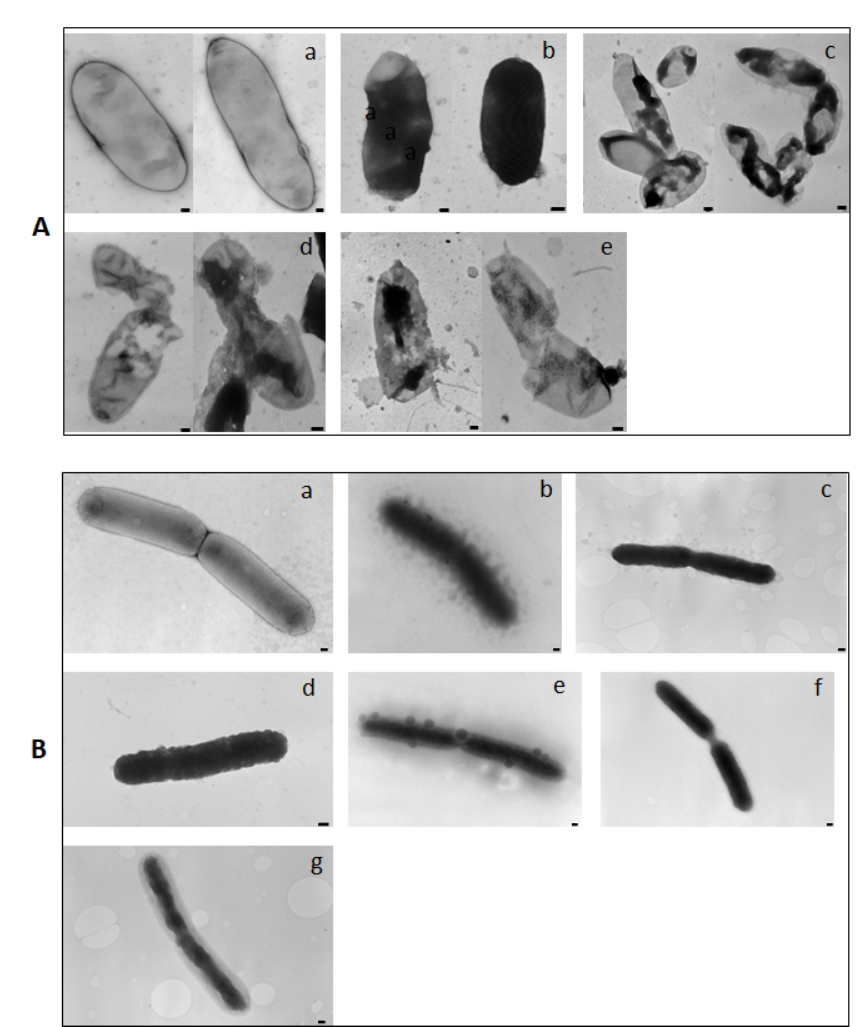
Figure 5. Transmission electron microscopy micrographs showing the bacteriostatic and bacteri- cidal activities of KL29 against Erwinia amylovora ( A ) and Xanthomonas campestris pv. campestris ( B ). A: (a) untreated cells of Erwinia amylovora ; (b) Erwinia amylovora cells treated with KL29 at 250 µM; (c) with streptomycin; (d) with KL29 at 50 µM; (e) with ampicillin. B: (a) untreated cells of Xanthomo- nas campestris pv. campestris ; Xanthomonas campestris pv. campestris cells treated with different con- centrations of KL29 at (b) 100 µM; (c) 50 µM; (d) 25 µM; (e) 12.5 µM; (f) 6.25 µM; (g) 2 µM. Bar = 100 nm.